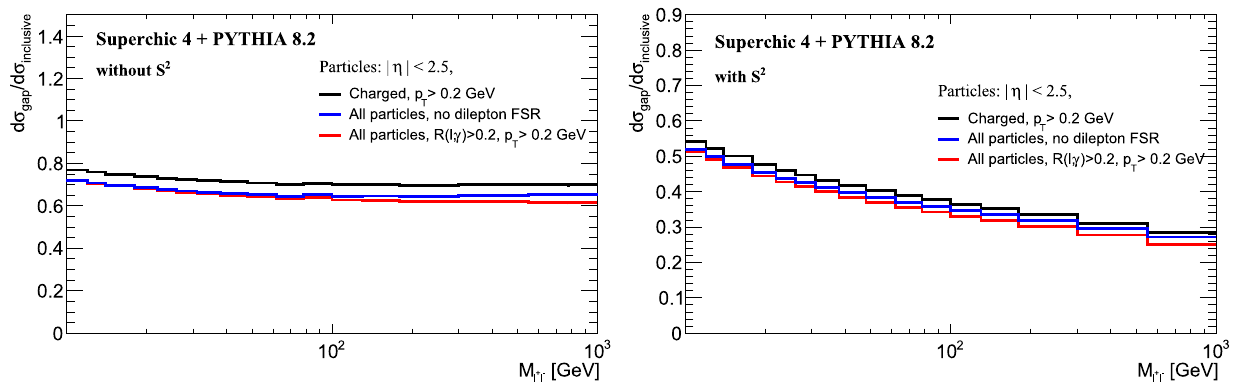
Fig. 3 The impact of the rapidity veto in the | η | < 2 . 5 region on the totalPIcrosssection.Weshowtheeffectofvetoingonallparticlesabove p ⊥ > 0 . 2 GeV, allowing photons within a cone of radius R = 0 . 2 to be present, as well as vetoing on charged particles only above p ⊥ > 0 . 2